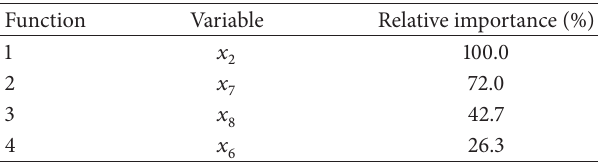
Table 3: The relative importance of four explanatory variables for MARS